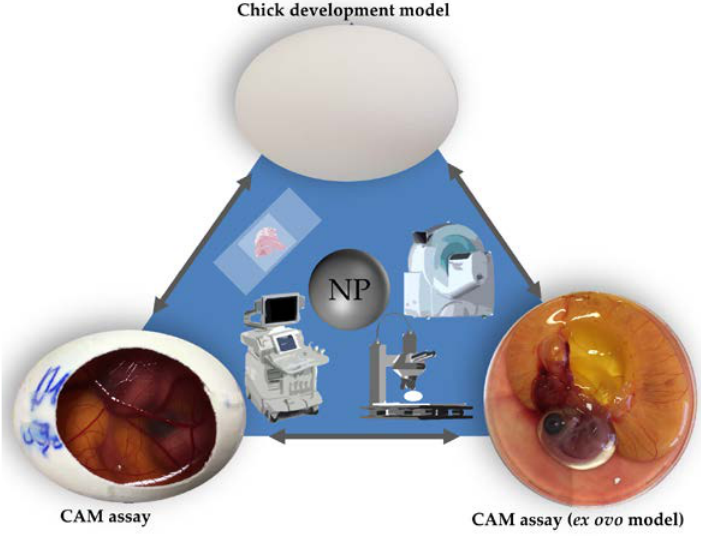
Figure 1. Three main in ovo techniques with associated imaging methods.